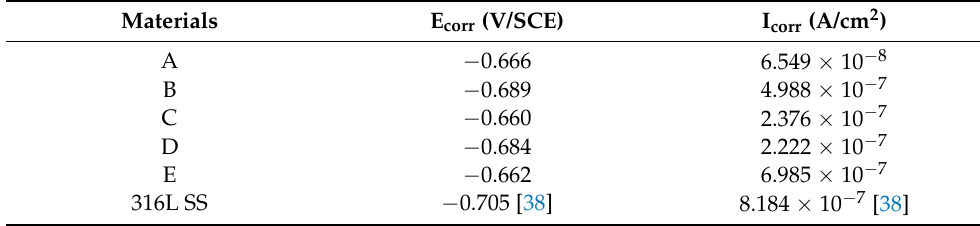
Table 3. The samples’ E corr and I corr .